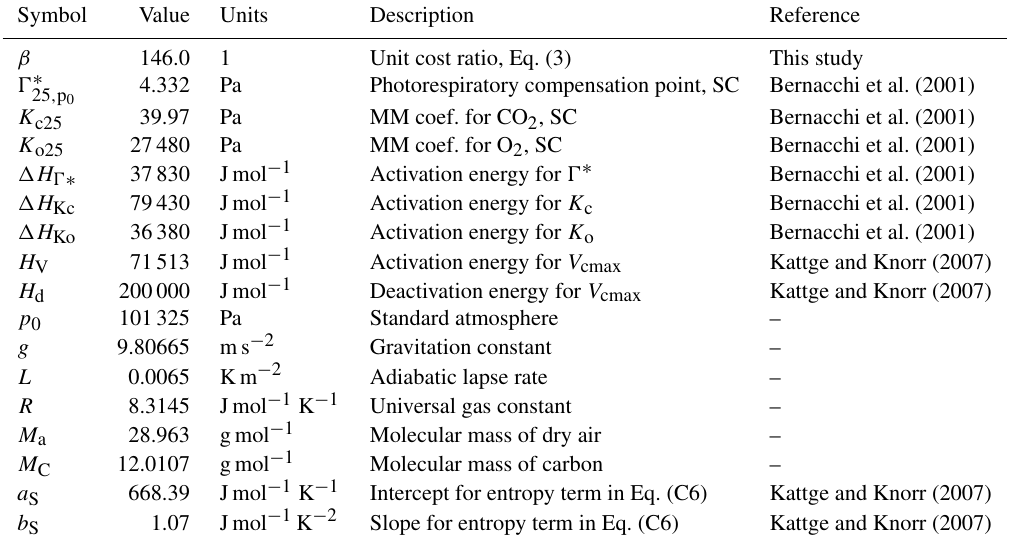
Table A2. Fixed parameters. “SC” stands for “at standard conditions” (25 ◦ C, 101325Pa). “MM coef.” refers to “Michaelis–Menten coeffi-